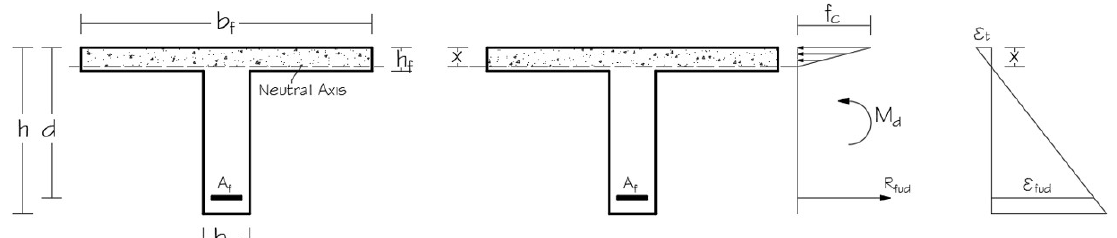
Figure 4. Equilibrium and compatibility conditions of a tension-controlled section with neutral axis on the flange and concrete exhibiting linear behavior